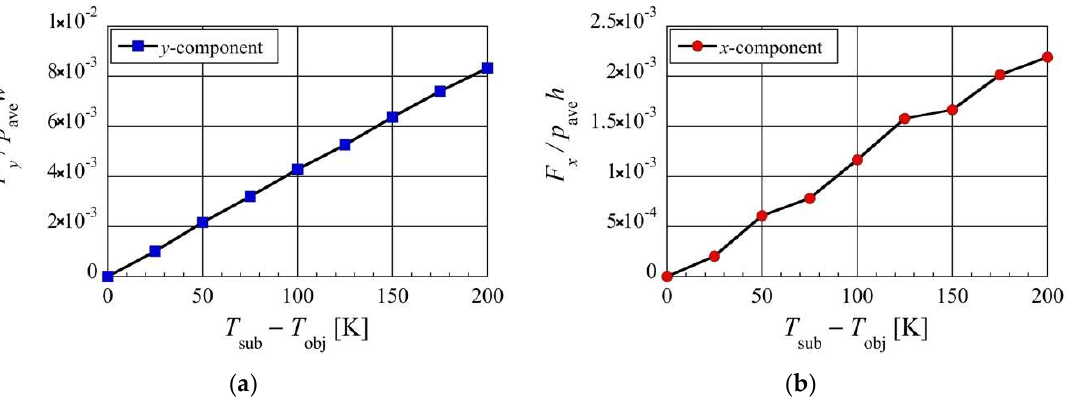
Figure 12. Net ( a ) upward and ( b ) rightward forces exerted on the beam at different temperature differences, in the case of Kn = 0.2 and T sub + T obj /2 = 400